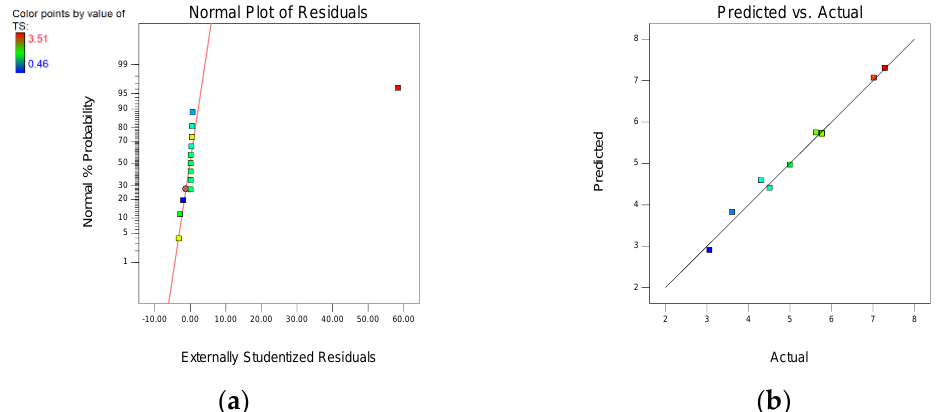
Figure 16. ( a ) Normal Plot for the Residual and ( b ) Predicted Versus Actual Plot for the CS model.